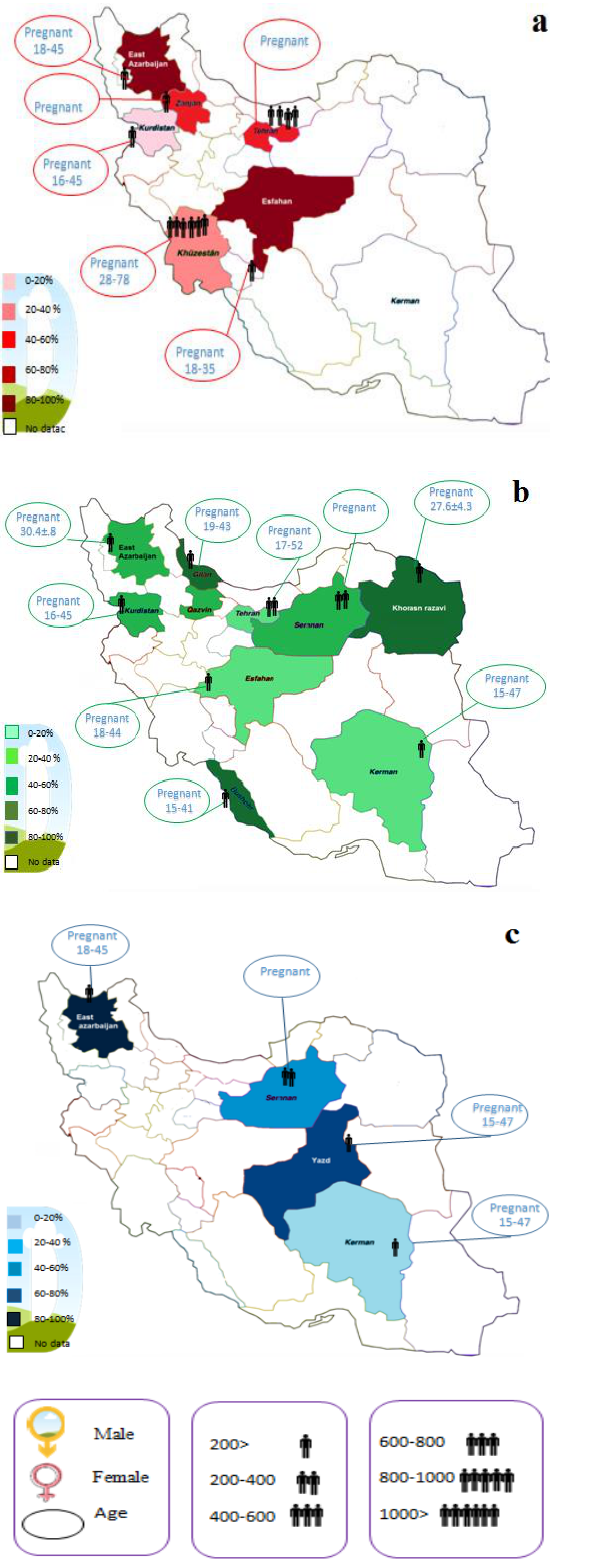
Figure 3 . The prevalence of vitamin D deficiency in Iranian Infants using cut-off values of 12 and 20 ng/ml, as well as prevalence of 25- (OH)-D levels <30 ng/ml (a, b, c,